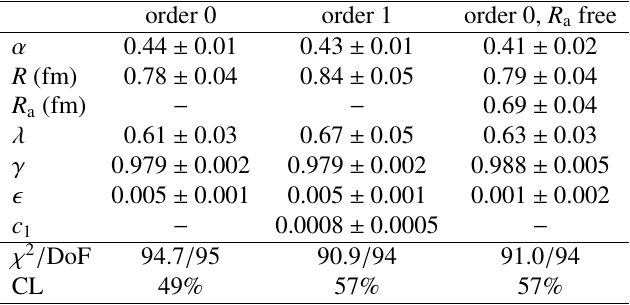
Table 1. Fit results of τ -model parametrizations for two-jet